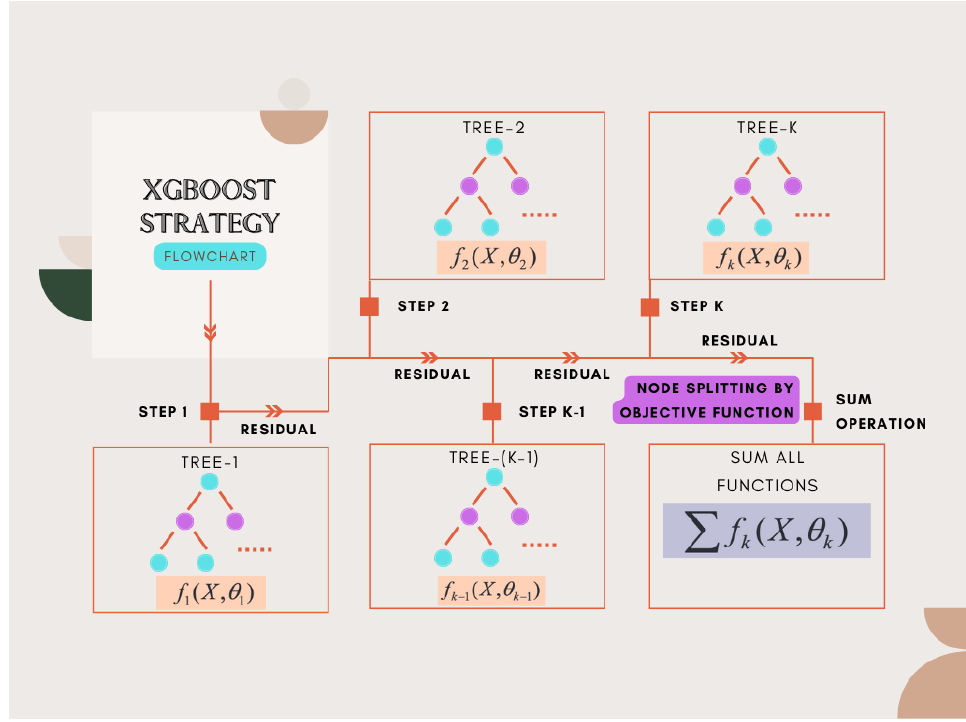
Figure 17. XGBoost flow